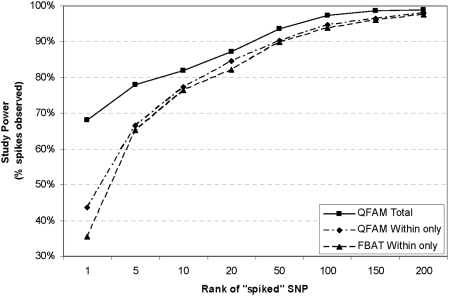
Inclusion of a between-family test of association increases study power using rank as a metric.A known effect comprising 1% of phenotypic variance explained was “spiked” into a dataset of 770 randomly selected SNPs with MAF≥0.01. Study power was evaluated for within-only (FBAT and PLINK/QFAM-Within) and within- and between-family (PLINK/QFAM-Total) tests of association. Across the 770 spiked datasets generated, study power is measured as the fraction of datasets in which the “spiked” SNP exceeds a particular rank. Ranking first out of 770 SNPs in each dataset approximates a rank of ≤440 in the context of a full genome-wide scan of ∼340,000 markers.